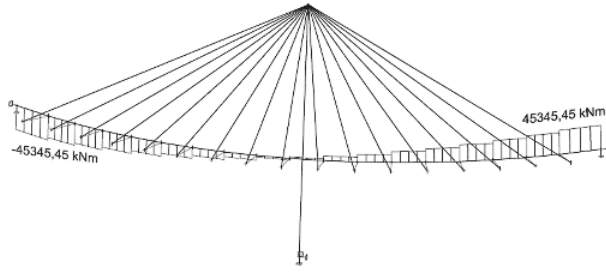
Figure 21 Torsional moment on curved deck (P): external